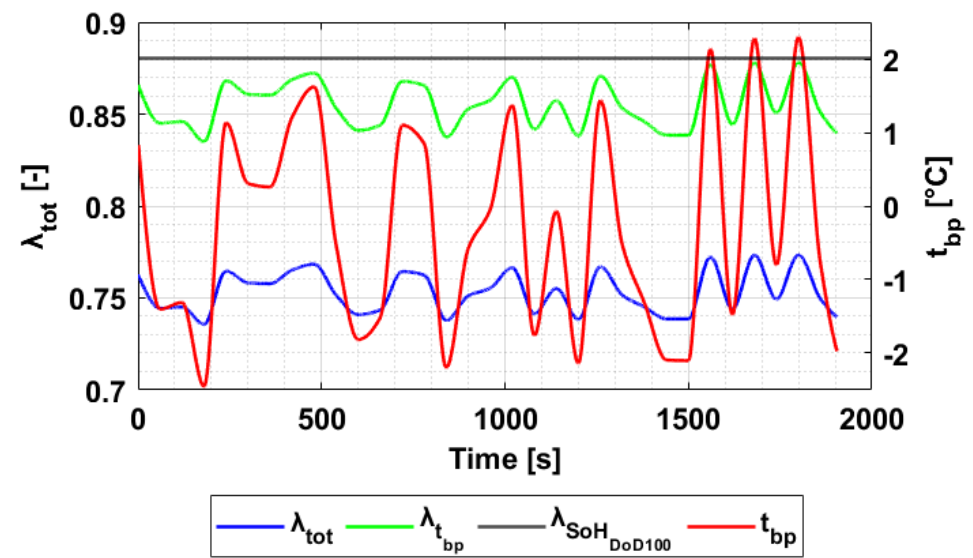
Figure 19. Combined effect of the battery pack temperature and the battery ageing level on 𝜆 𝑡𝑜𝑡 for DM25 in the case of a battery with 200 life-cycles completed and DoD100.